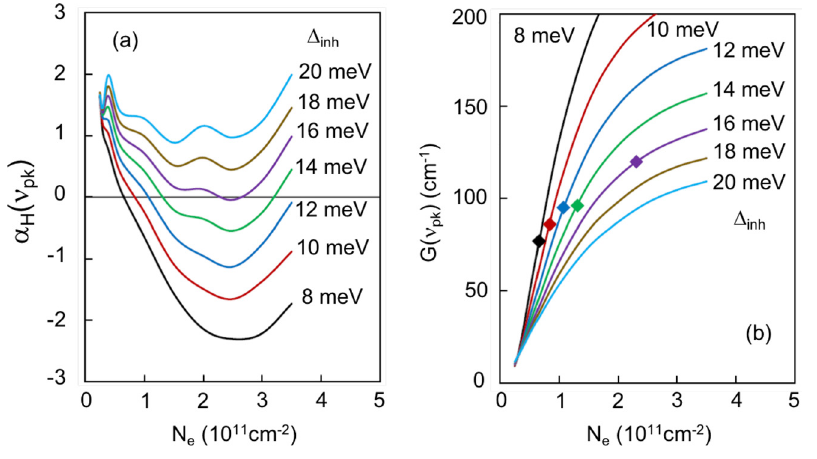
Figure 5: (a) Linewidth enhancement factor ( α H -factor) at gain peak and (b) peak gain versus carrier density for ground-state transition, 10 12 cm − 2 p-dope density and inhomogeneous widths as indicated. The diamonds show the peak gains when α